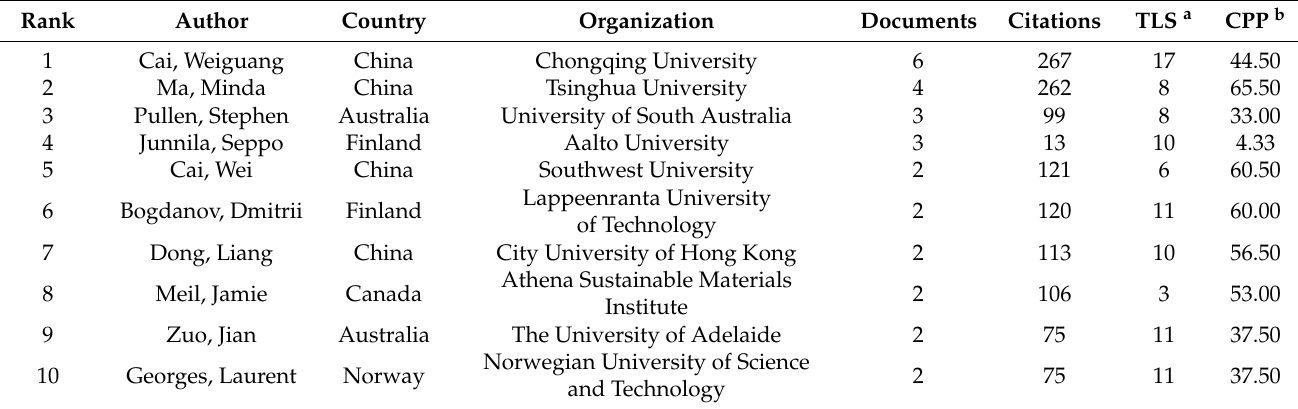
Table 2. Top 15 authors with the most publications on CPCN in buildings.